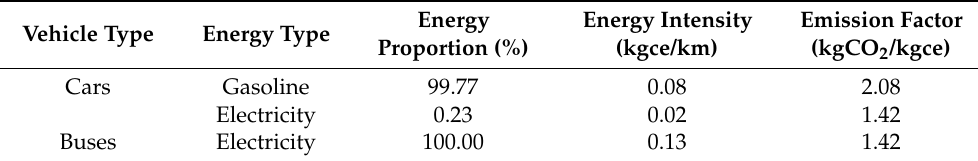
Table 2. Parameters of vehicular energy in International Low-Carbon City (ILCC) Core Area in